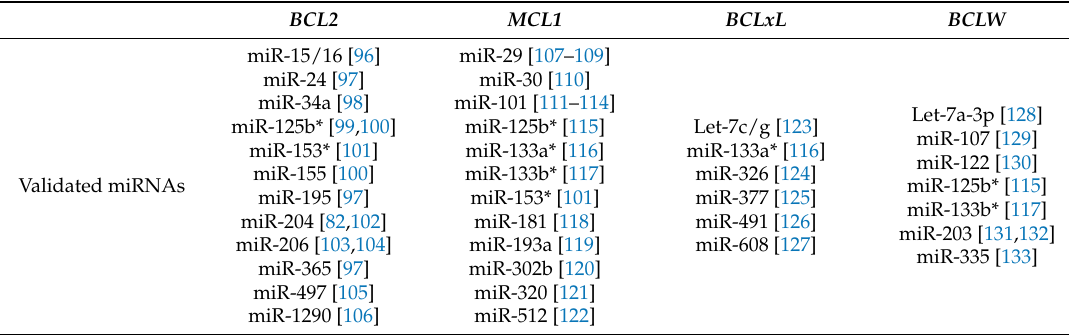
Table 3. Validated miRNAs targeting BCL2 , MCL1 , BCLxL , and BCLW